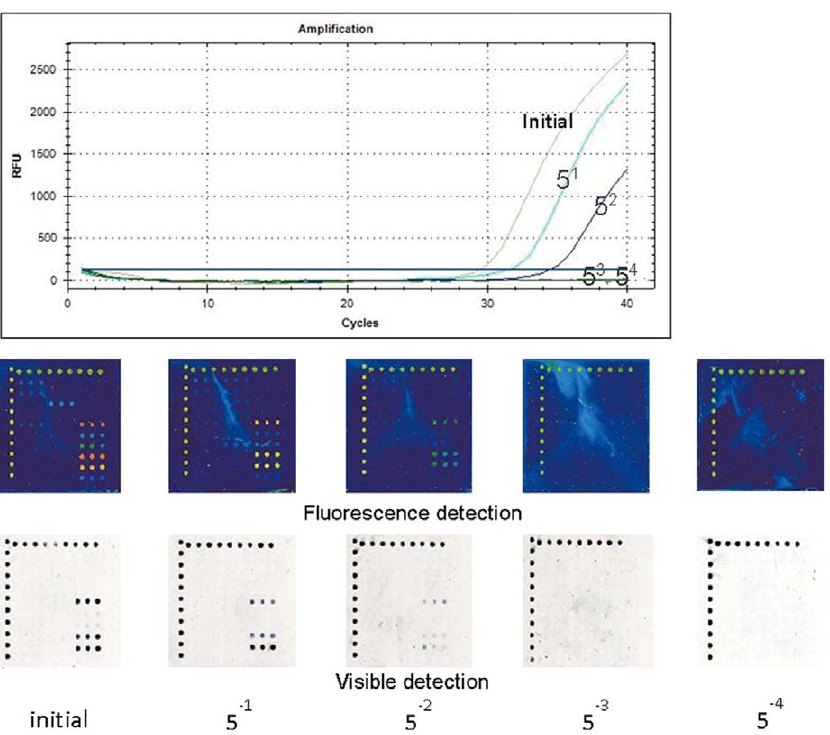
Figure 3. The sensitivity comparison results of 2009 influenza A (H1N1) a . a The real-time RT-PCRs were amplified by the CFX96 Touch TM Real-Time PCR Detection System (Bio-Rad). Five dilutions (initial, 5 1 , 5 2 , 5 3 , and 5 4 ) of 2009 influenza A (H1N1) templates, the extracts of clinical throat swab samples, were amplified to compare the sensitivity of our microarray with that of the Influenza A virus (H1N1) Nucleic Acids Detection Kit (coProbes Real-Time PCR) (Shenzhen Puruikang Biotech Co., Ltd.). All three methods could detect templates at 5 2 dilutions, so they had similar sensitivities. The sensitivity comparison results of the other two subtypes showed similar conclusions (the results were no shown).